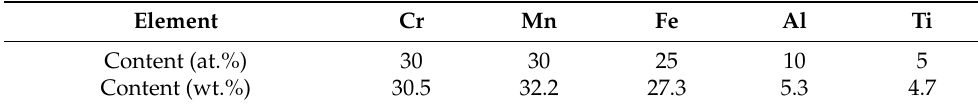
Table 1. Elemental composition of Al 10 Cr 30 Fe 25 Mn 30 Ti 5 HEA. Element Cr Mn Fe Al Ti Content (at.%) Content